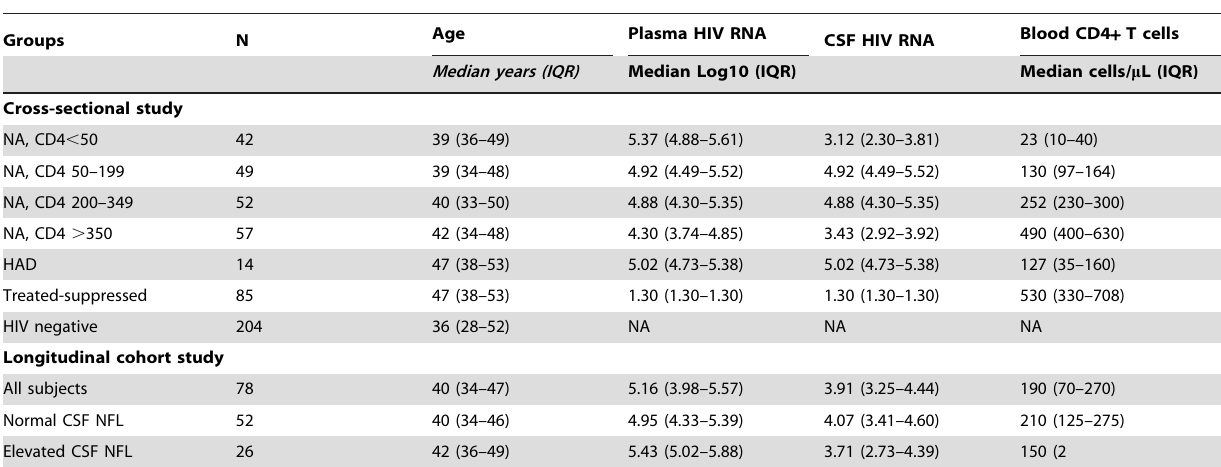
Table 1. Background subject characteristics.